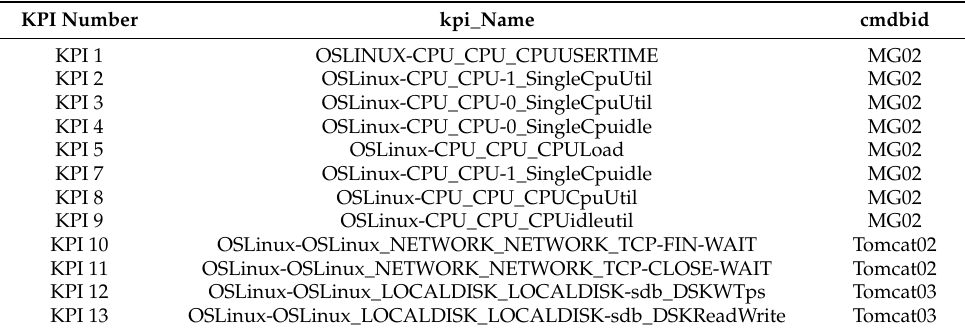
Table 6. KPIs used in the first set of correlation analysis.